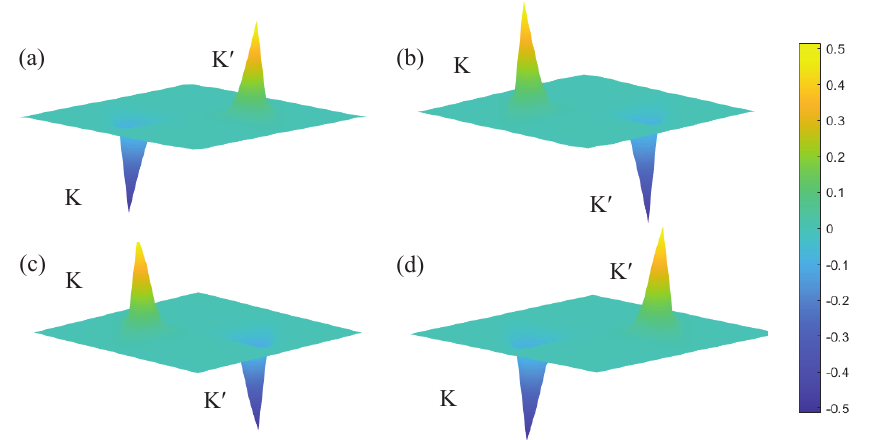
Figure 3. Berry curvatures: ( a ) upper valley band of α = 3 ◦ ; ( b ) lower valley band of α = 3 ◦ ; ( c ) upper valley band of α = − 3 ◦ ; ( d ) lower valley band of α = − 3 ◦ . The valley Chern numbers are computed by integrating the Berry curvature. When α = 3 ◦ , the upper valley Chern number C + α equals − 0.41, which is inconsistent v − 1